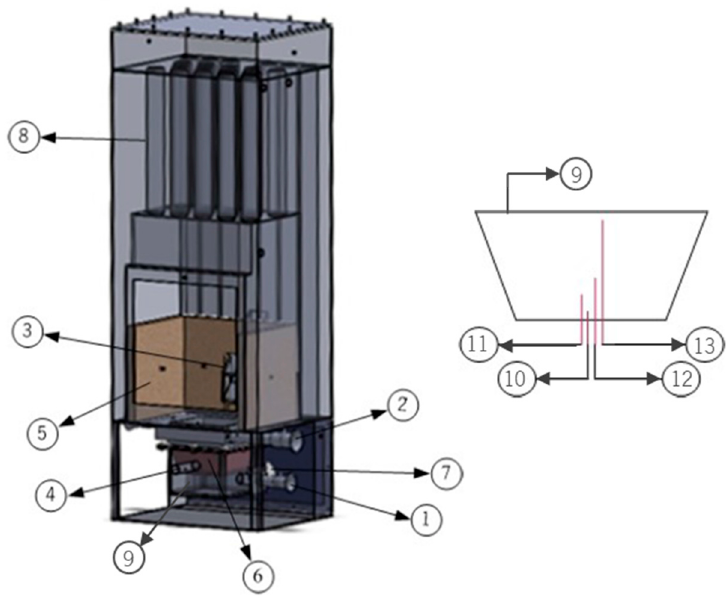
Figure 2. Boiler unit and Fuel Bed representation, adapted from [19]: 1. Primary air duct; 2. Secondary air duct; 3. Fuel Inlet; 4. Ignition Coil; 5. Fire Clay Slabs; 6. Grate; 7. Stack; 8. Heat Exchanger; 9. Fuel Bed; 10–13. Type K Thermocouples at 5, 15, 25 and 60 mm height, respectively.